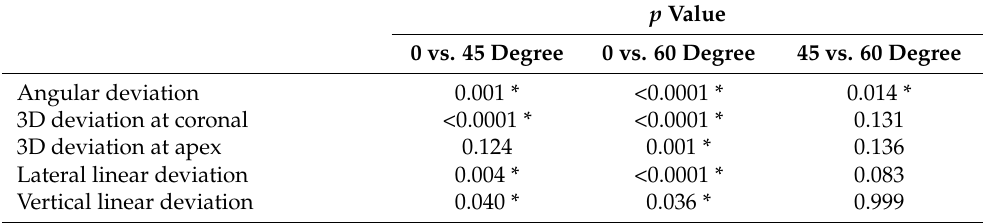
Table 13. The multiple comparisons of the accuracy of implant placement in varying bone